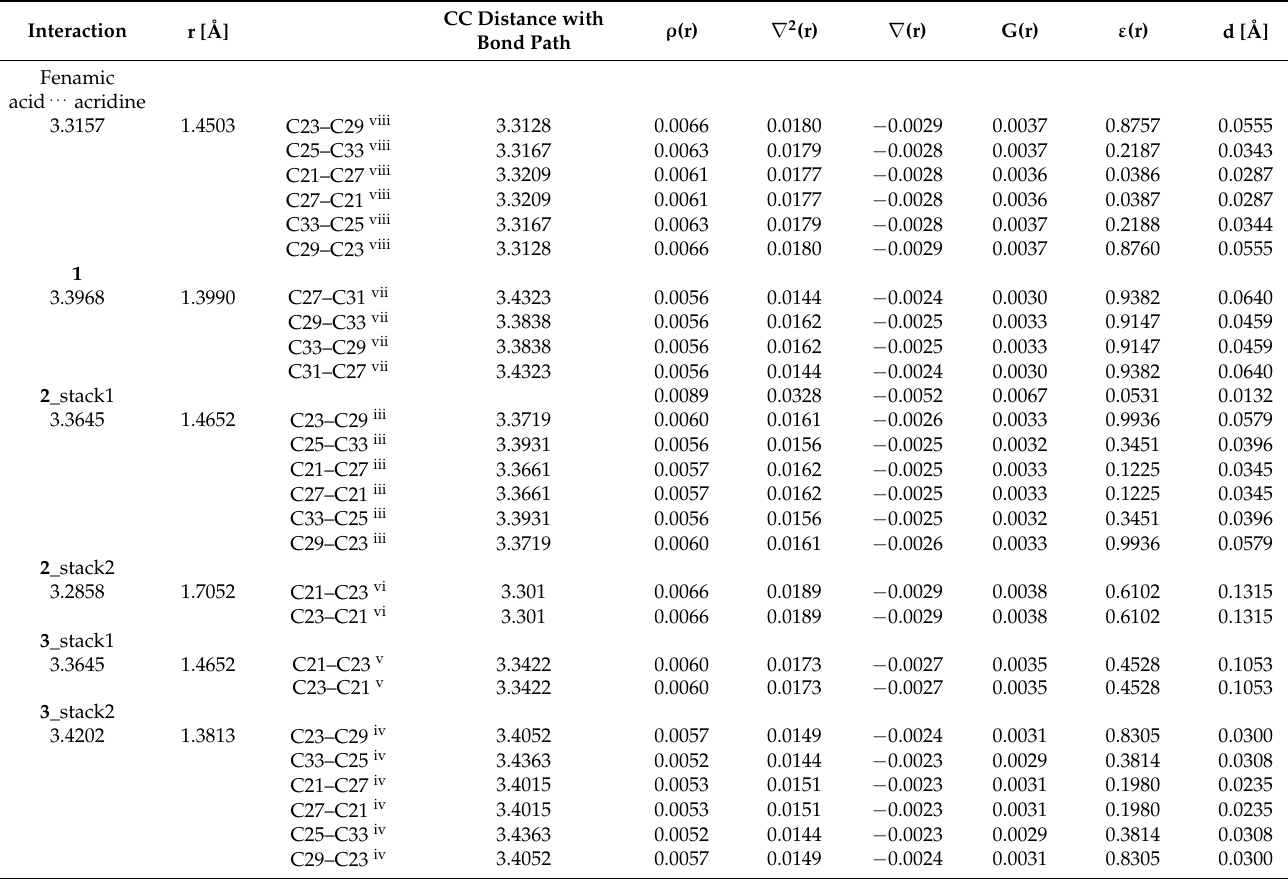
Table 4. Geometrical and QTAIM stacking parameters for acridine rings in fenamic acids–acridine complexes.